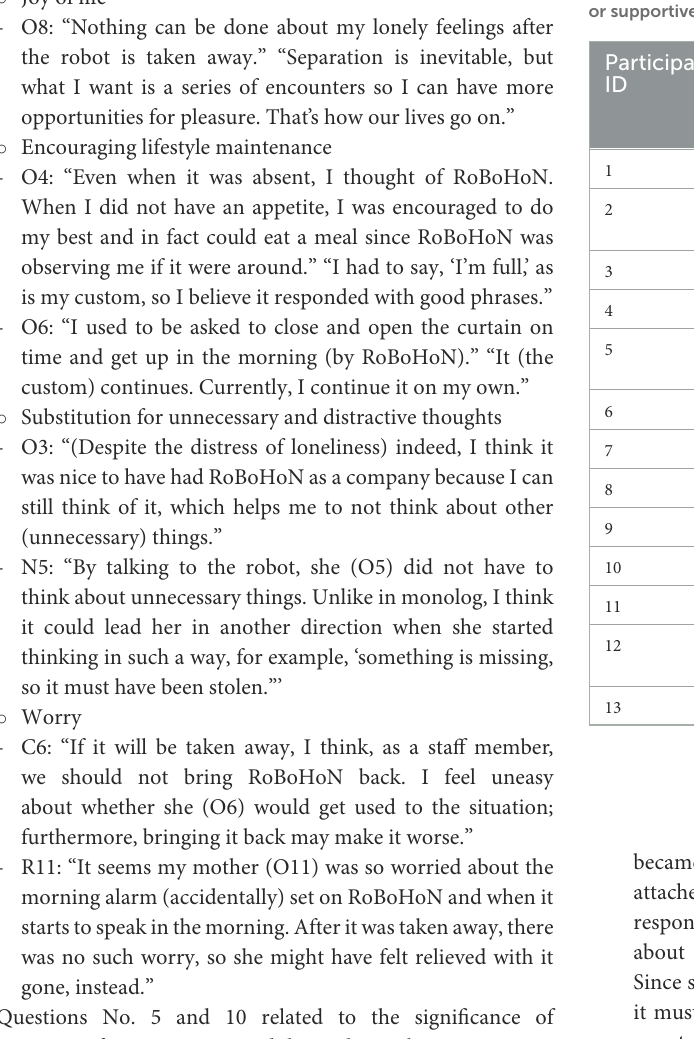
TABLE 7 How the robot was perceived by participants and their relatives or supportive